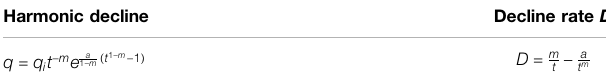
TABLE 3 | Decline-curve equations proposed by Duong (2010). Harmonic decline Decline rate D